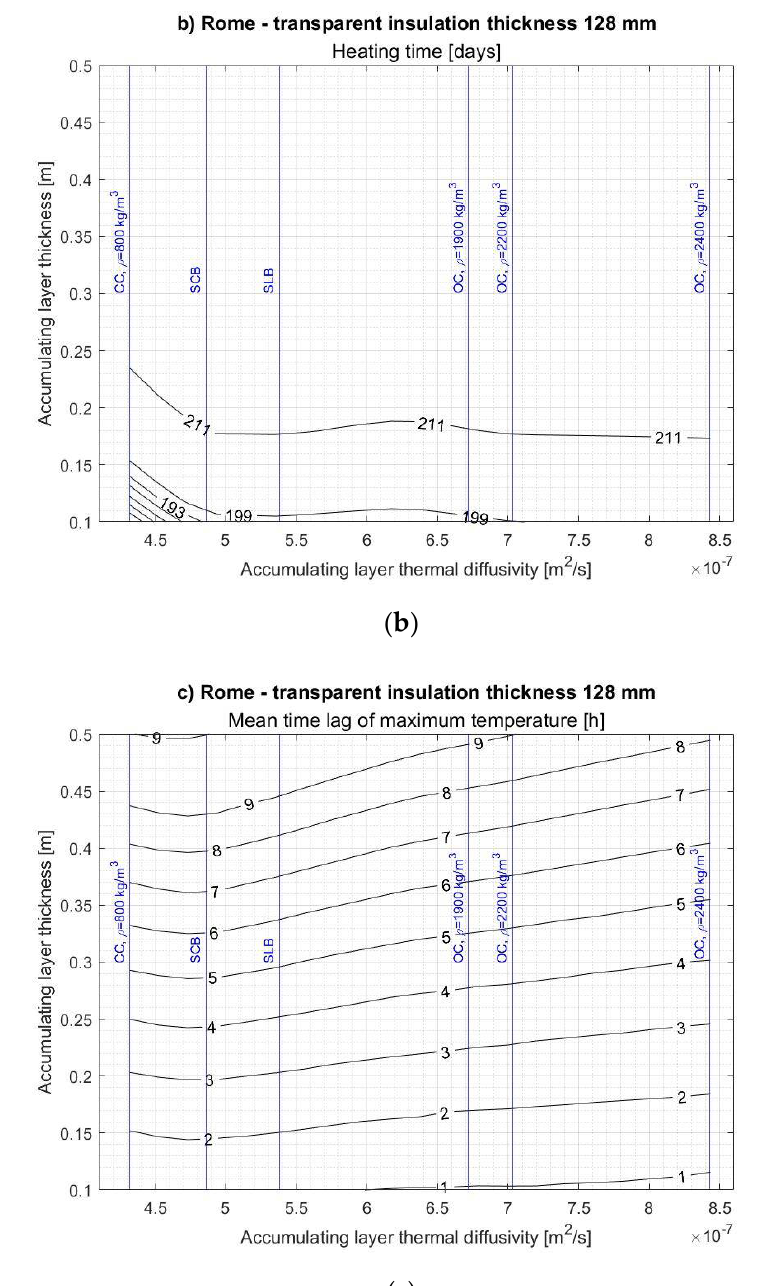
Figure A12. Cont